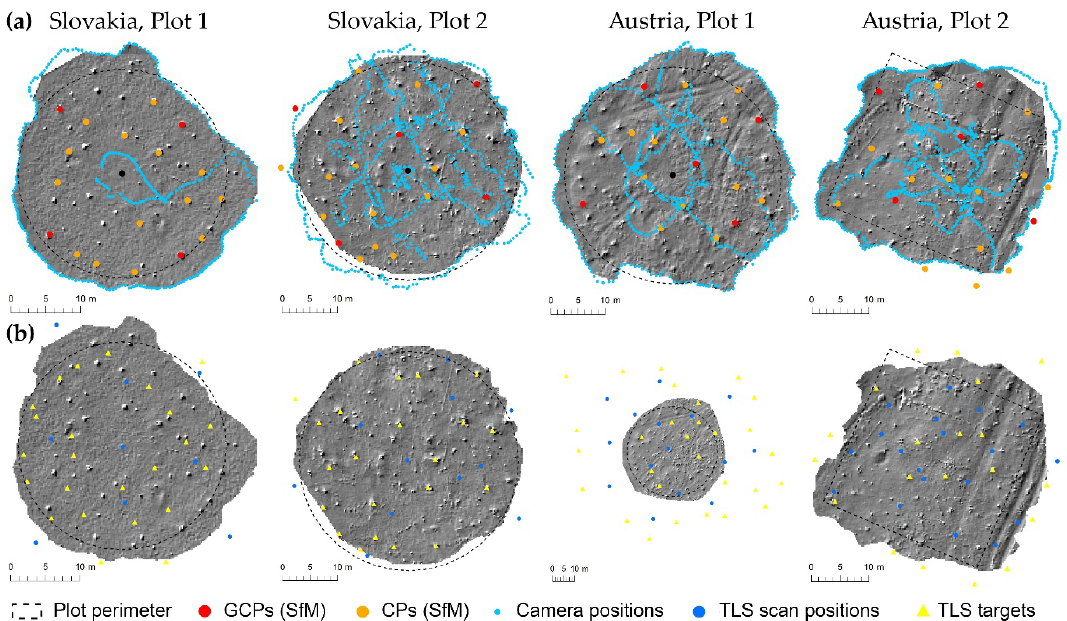
Figure A2. For each forest plot, the hillshade DTM generated from the interpolation of (a) the SfM and (b) the TLS point cloud. On the SfM hillshade, we overlay the camera location (light blue dots), the GCPs (red dots) and CPs (orange dots) while in the TLS hillshade the scan positions (blue dots) and the TLS targets (red dots) are reported. The black dot in the SfM hillshade indicates the centre of the plot and the black dash line approximates the plot boundary.